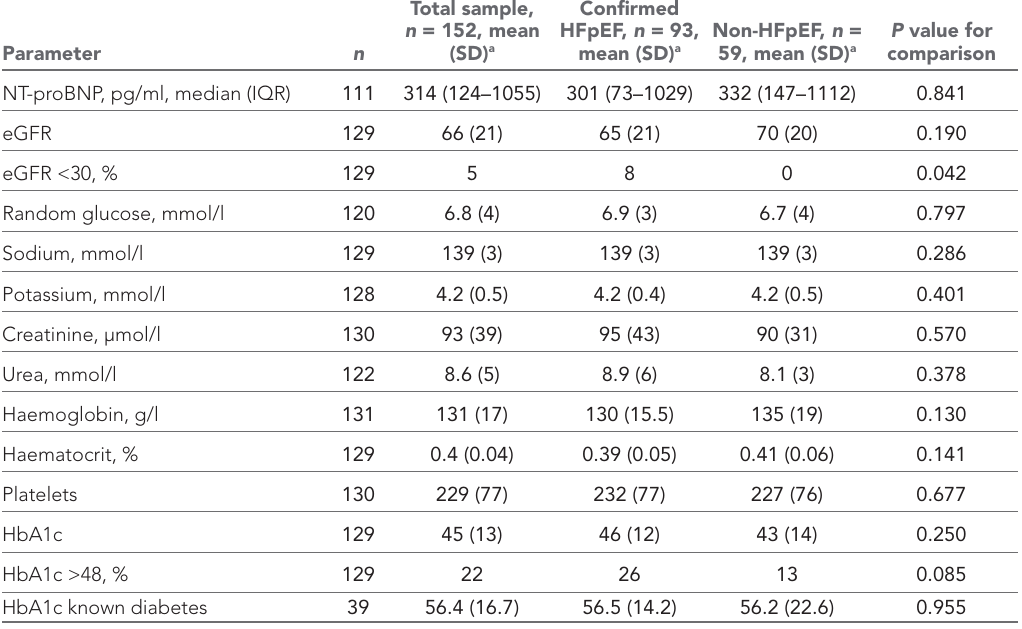
Table 2 Laboratory values by HFpEF